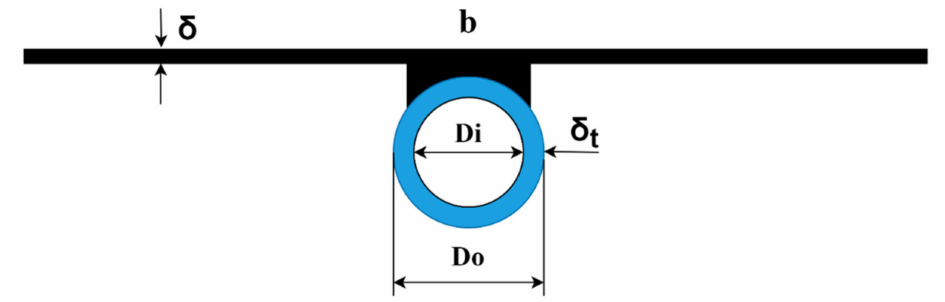
Figure 8. Nomenclature for the arrangement of the absorber plate and